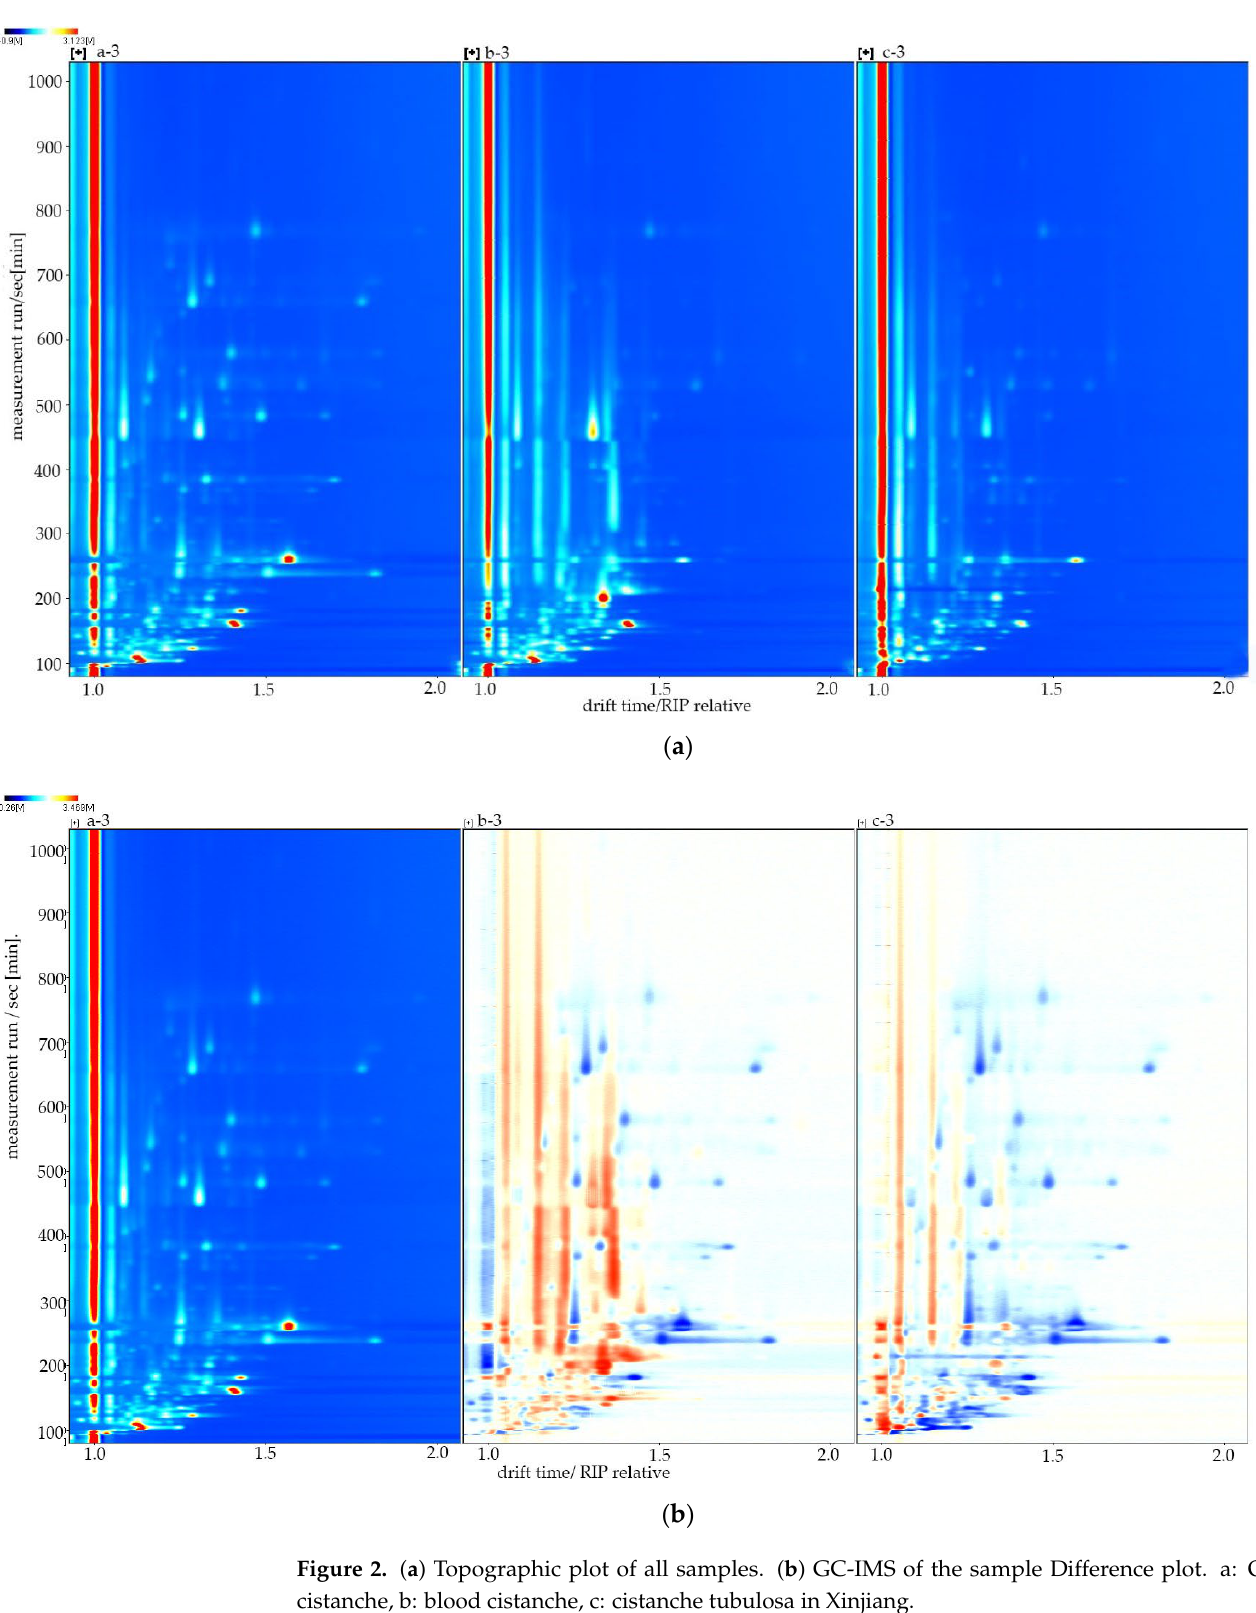
Figure 2. ( a ) Topographic plot of all samples. ( b ) GC-IMS of the sample Difference plot. a: Oil cistanche, b: blood cistanche, c: cistanche tubulosa in Xinjiang. cistanche, b: blood cistanche, c: cistanche tubulosa in